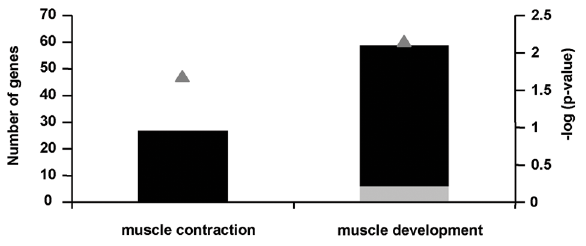
Figure 6. 2-AA treatment down-regulates muscle function. Black bars indicate the number of down-regulated genes; gray bars indicate the number of up-regulated genes, in the skeletal muscle of mice 4 days post 2-AA treatment versus control mice (left vertical axis). The negative log10 of p-values represented by gray triangles are indicated on the right vertical axis.